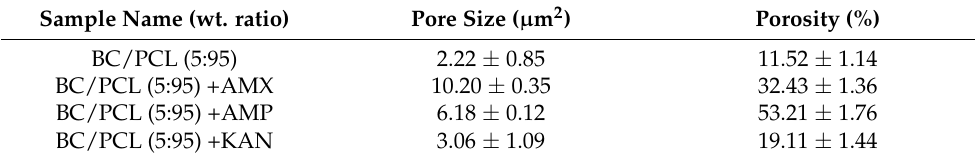
Table 2. Pore size and porosity of EHD-3D printed patches. (Mean ± SD, n = 3). Sample Name (wt. ratio)